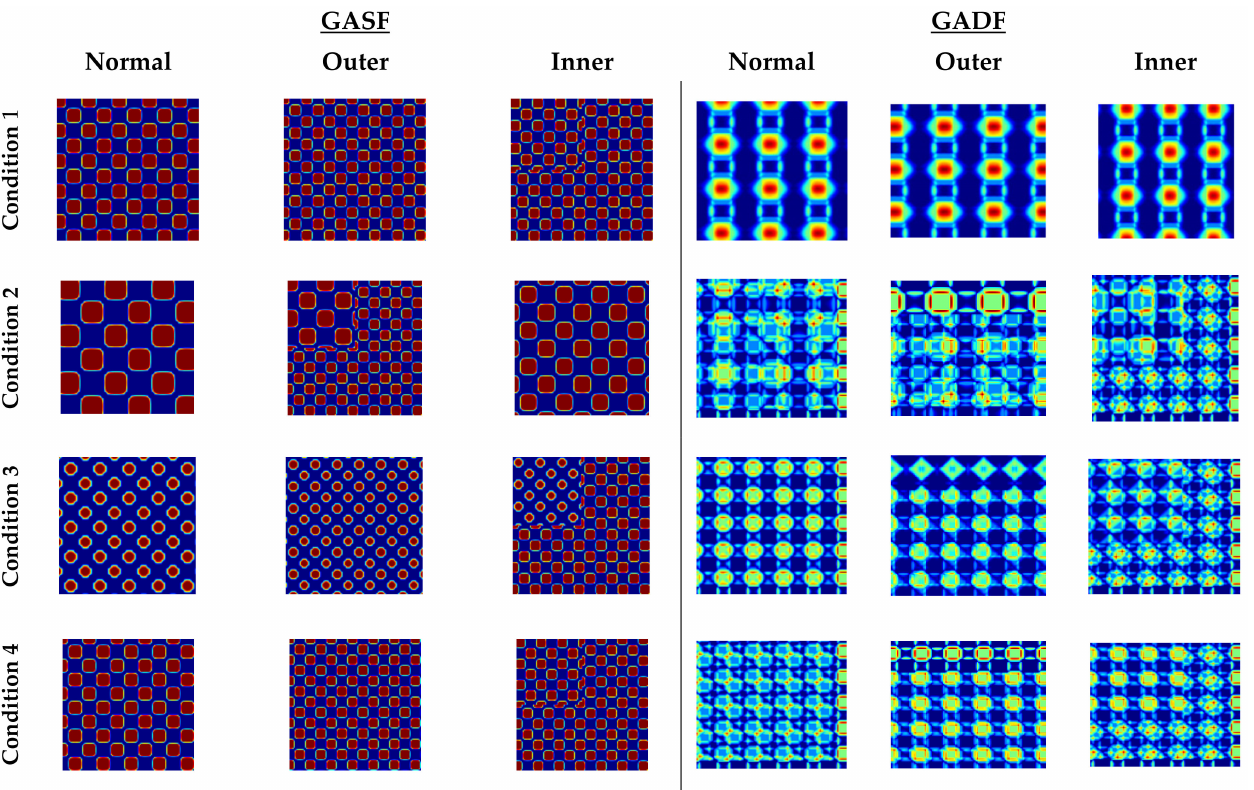
Figure 7. The resultant 2-D images after applying GASF and GADF algorithms on four considering working conditions.